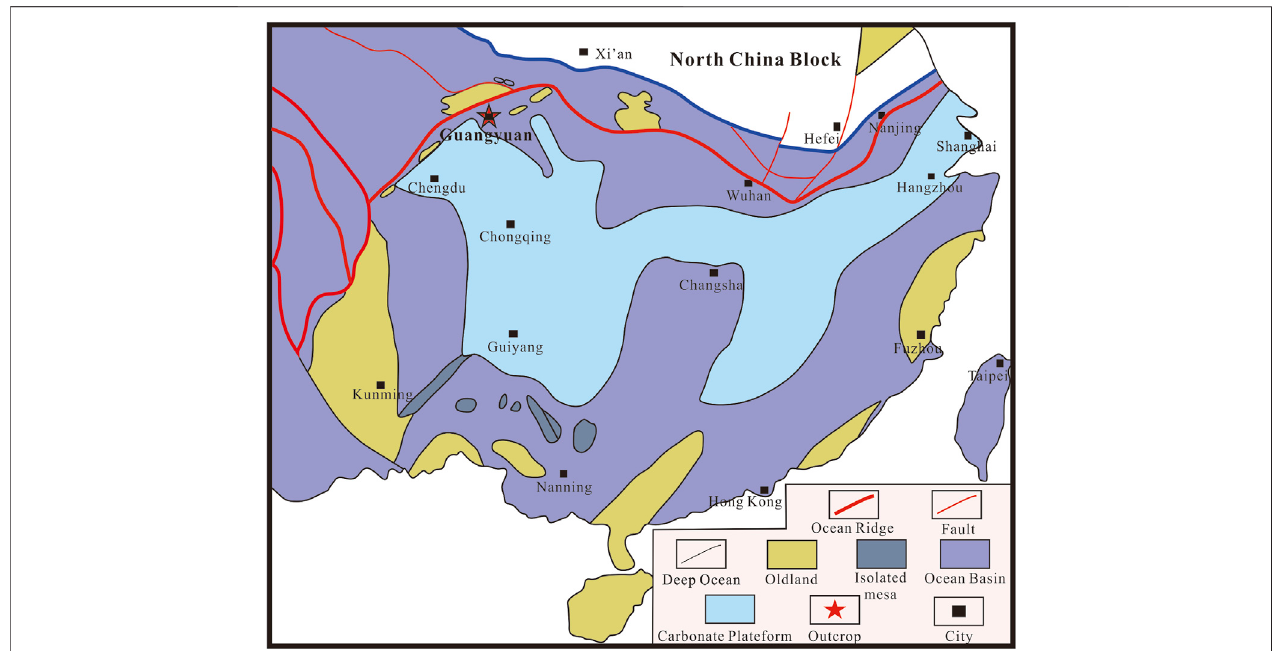
FIGURE 1 | Outcrop location (modi fi ed after Meng et al.,